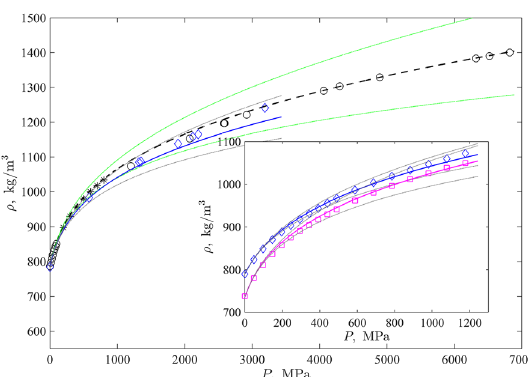
Figure 2. Experimental 32 densities at T = 298.15 K for liquid methanol up to 6.82 GPa (black circles) and ethanol up to 3.19 GPa (blue diamonds) in comparison to the predicted density isotherms (black dashed and blue solid curves, respectively). To fill the gap in the region of maximal curvature of the isotherm, the data generated by the NIST REFPROP Database 30 from 200 MPa to 800 MPa with the step 100 MPa are shown as black asterisks. Inset: Bridgman’s data 29 for ethanol’s isotherms T = 293.15 K (blue diamonds) and T = 353.15 K (magenta squares) and the predicted isotherms shown as solid curves of the corresponding colours. Thin green (for methanol) and gray (for ethanol) lines highlight over- and under-estimation of data by the Tait and Murnaghan equations,